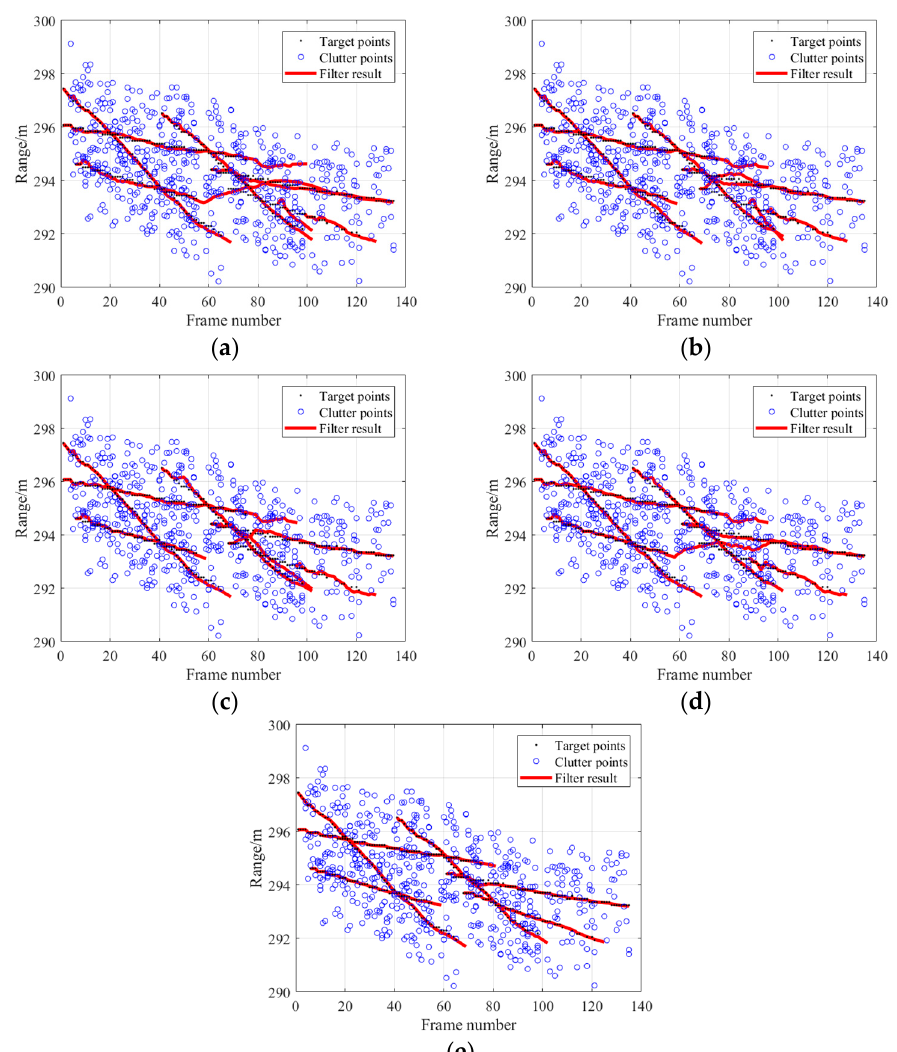
Figure 13. Filtering result comparisons: ( a ) cheap JPDA, ( b ) suboptimal JPDA, ( c ) JPDA, ( d ) ITT-NoMFF, ( e ) ITT-MFF. Table 7 . Running time comparison (Unit: